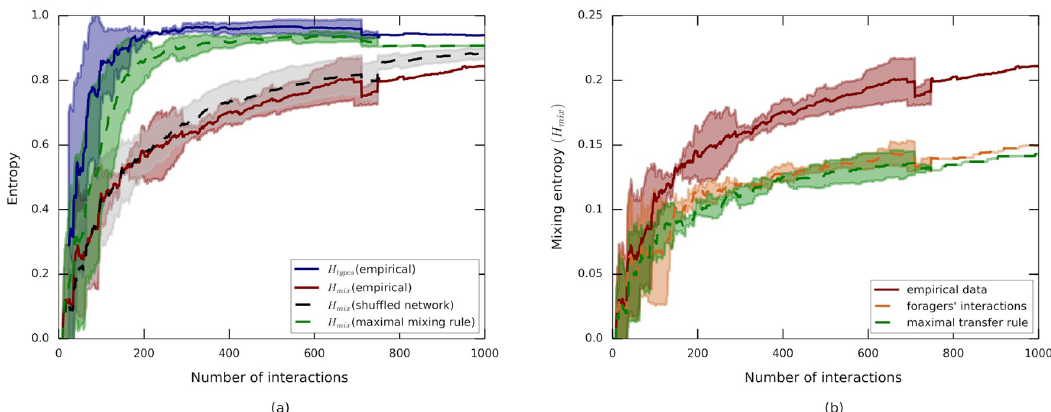
Fig 4. Mixing as a function of the number of interactions. Plots compare empirical data and hybrid simulations. Entropies are normalized by log ðj F jÞ , solid lines show the empirical mean over the three experiments, dashed lines represent means over hybrid simulations. Shaded areas depict standard deviations. (a) The mixing entropy, H mix , in simulations with maximally mixing interactions applied over the empirically measured network (green curve) nearly saturates the empirically assessed upper bound H types (blue curve). Mixing entropy, H mix , in simulations where the empirically derived interaction rule is applied over maximally mixing interaction networks shows a limited rise which compares with empirical mixing rates (red curve). (b) Hybrid simulations of two extreme interaction rules preserving the empirically measured interaction schedule. The orange curve shows H mix using only the transfers between foragers and non-foragers ( i.e ., all non-forager to non-forager interactions were set to zero). The green curve depicts H mix where every transfer is assumed to be at its maximal possible volume. These rules lead to mixing levels that are lower than those measured experimentally (red curve). Discontinuities in the plots are a consequence of the variable number of interactions among the three